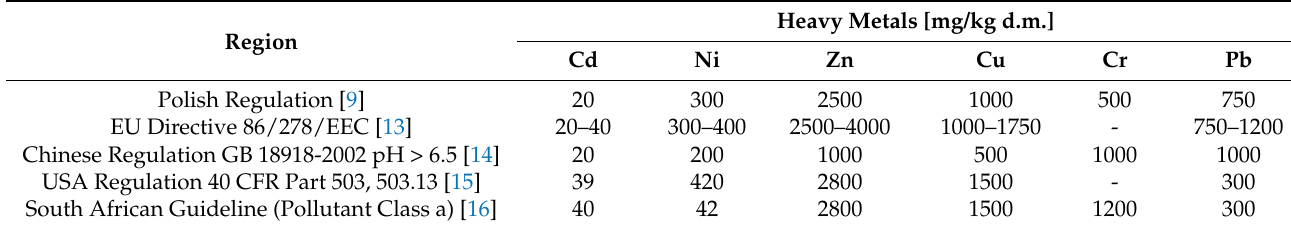
Heavy Metals [mg/kg d.m.]